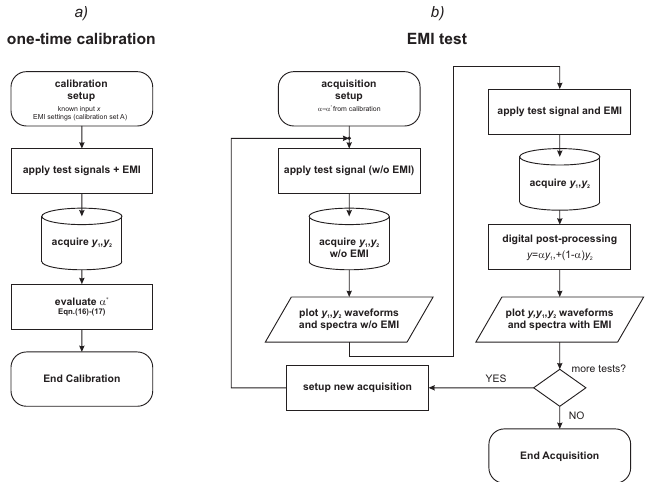
Figure 6. Flow chart of the calibration procedure ( a ) and of the EMI test procedure ( b ) adopted to test the susceptibility of the proposed